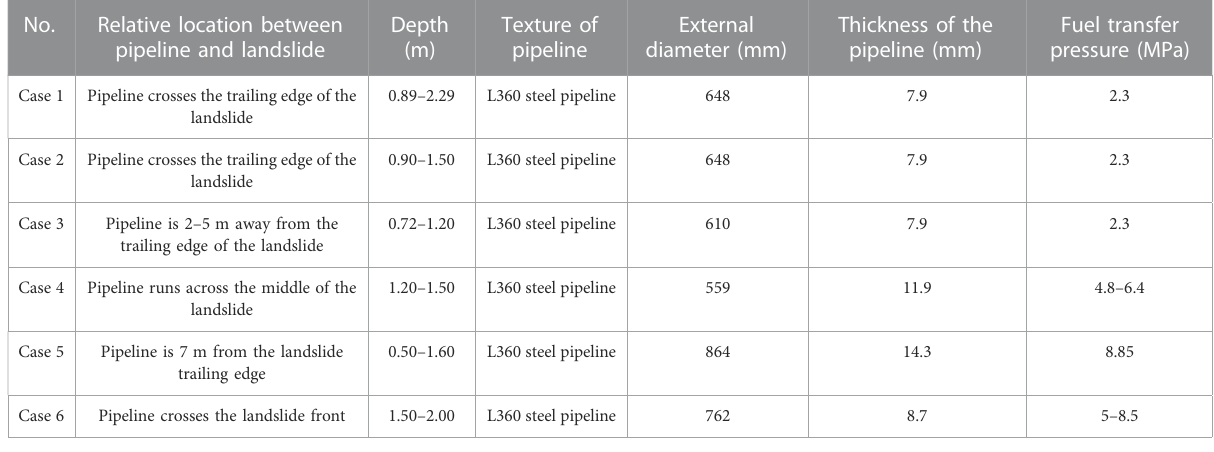
TABLE 2 Statistics of pipeline parameters in typical pipeline landslide cases. No.